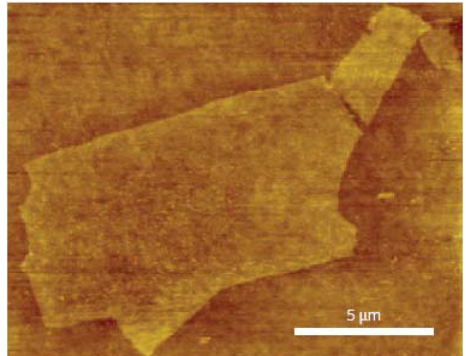
Figure 8. Atomic force microscope (AFM) image of a large scale graphene. Reprinted with permission from [87]. Copyright (2009) by the Macmillan Publishers